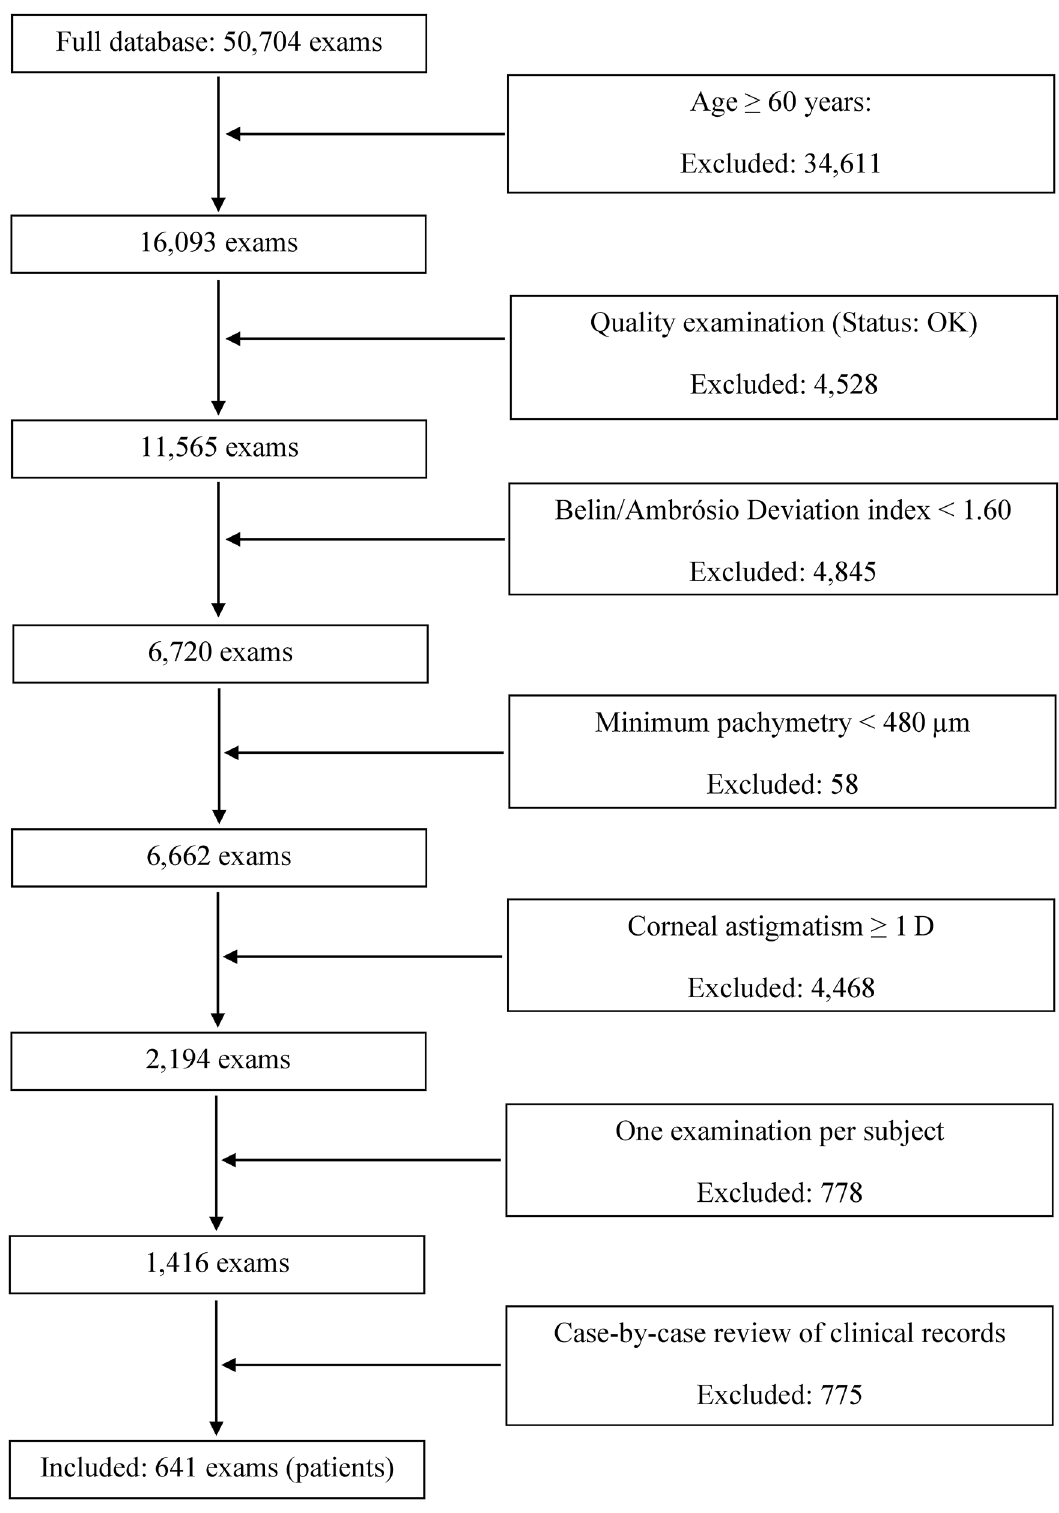
Figure 1. Flow diagram of the process of selection of cases from the patient-examination